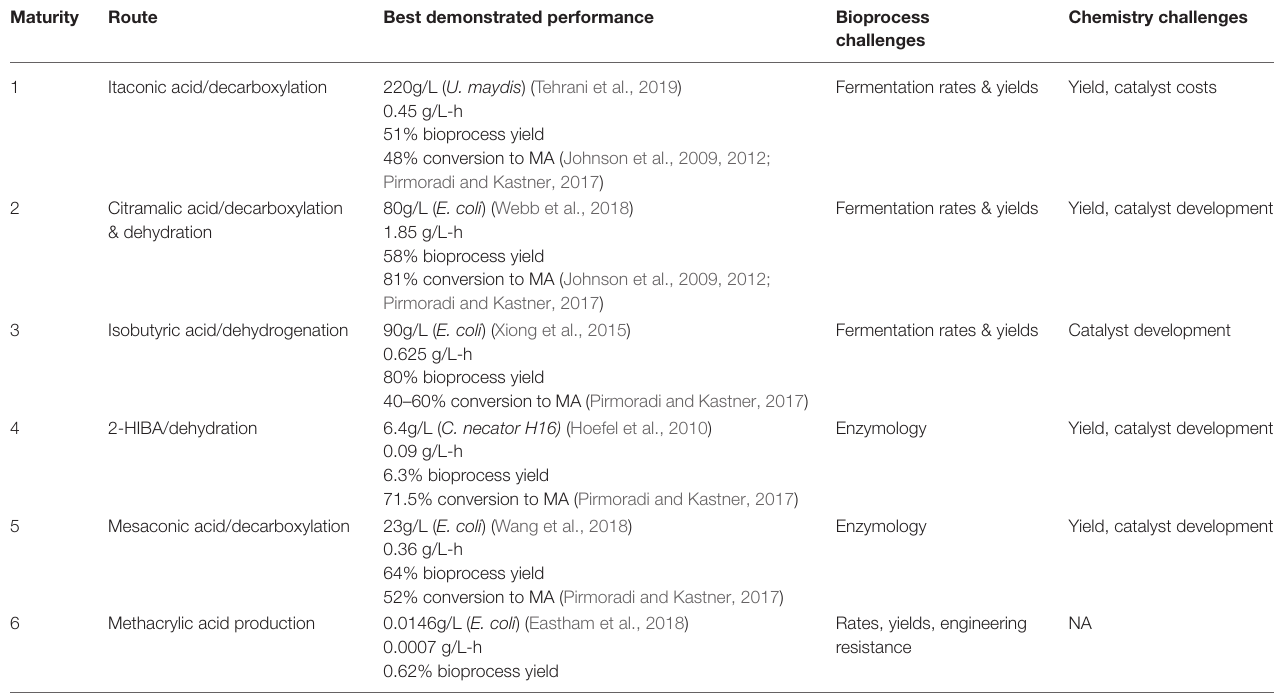
TABLE 1 | Comparison of maturity and challenges for biobased routes to